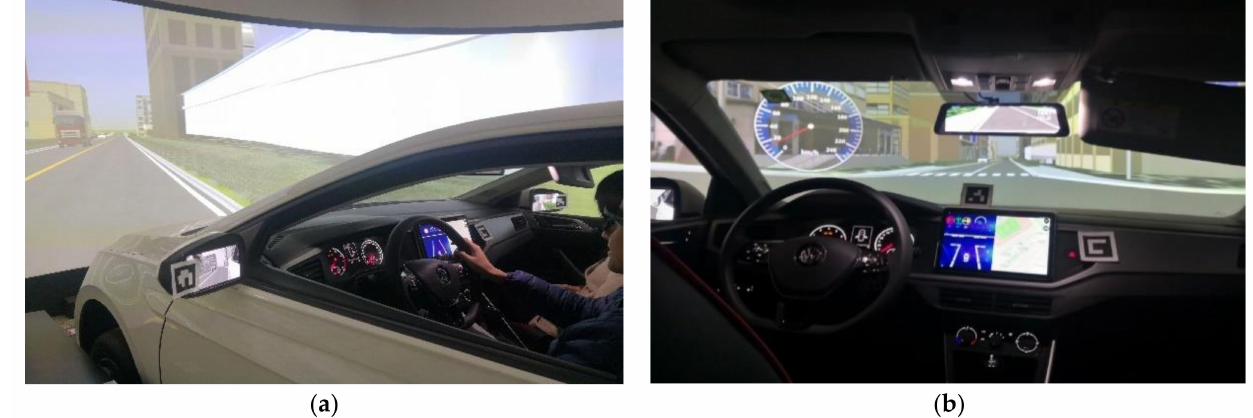
Figure 9. Simulation tests of V2I-based side-collision warning model for non-signalized intersections. ( a ) External environ- ment during test. ( b ) Interior environment during